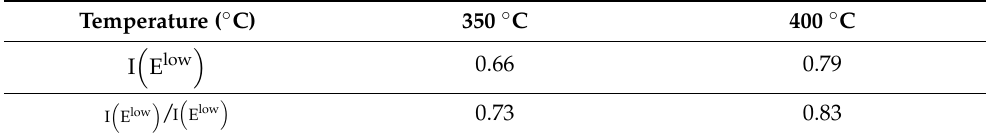
Table 2. The intensity of the E low mode and the intensity ratio of (E low /E High ) modes of the FeS 2 sample at different